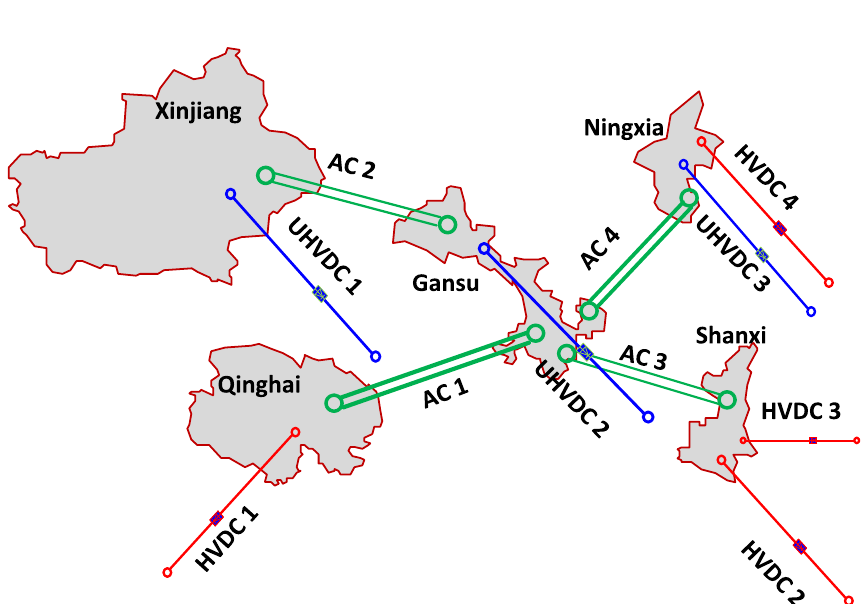
Fig. 3 Tie-lines map of Northwest region of China